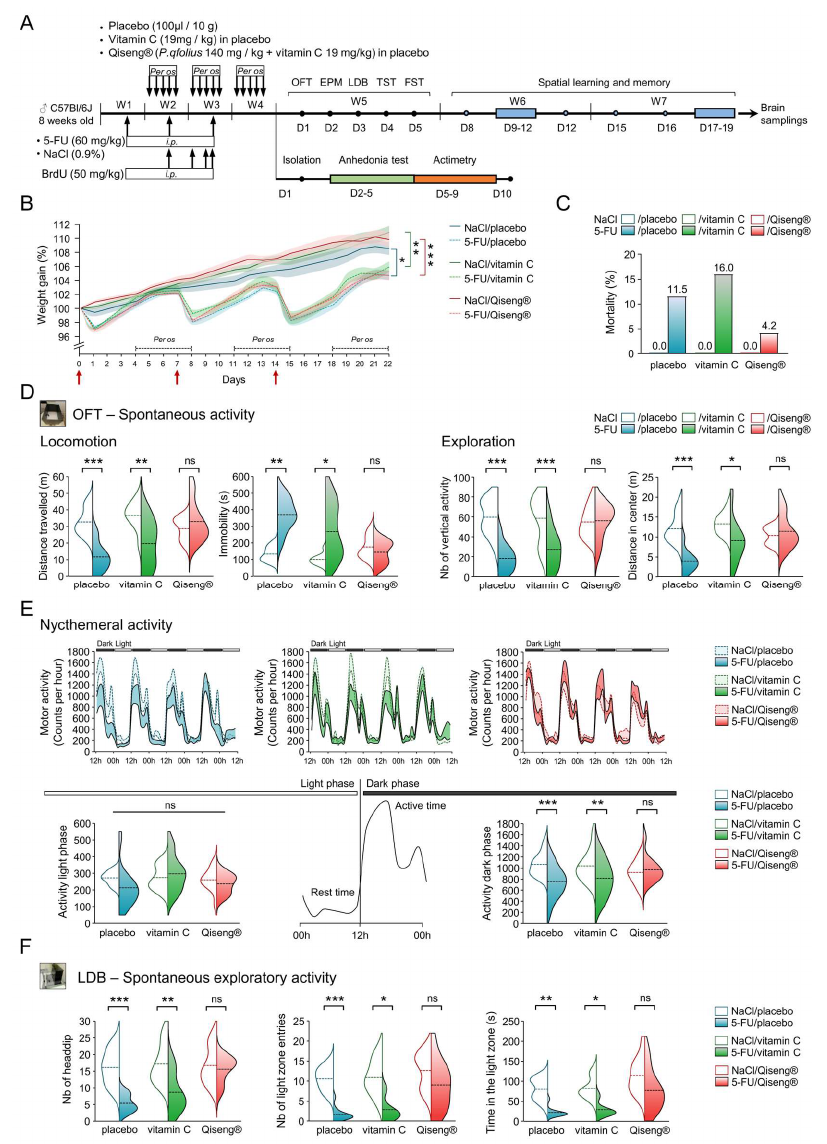
Figure 1. Preventive impact of Qiseng ® on the behavioral consequences of 5-FU for spontaneous activity and exploration and nycthemeral rhythms and activity. ( A ) Schematic representation of the schedule and experimental protocol showing the timeline for the different treatments and behavior tests assessing emotional reactivity and cognitive functions in mice. C57BL/6J Rj mice received intraperitoneal injection of 5-FU (60 mg/kg, red arrow) once a week for 3 weeks (i.p., arrow ) and/or per os administration of Placebo, vitamin C (19 mg/kg) in placebo or Qiseng ® ( P. qfolius 140 mg/kg + vitamin C 19 mg/kg) once a day, 5 times a week for 3 weeks. Mice also received consecutive BrdU injections (50 mg/kg, once a day for 4 days, arrow ) in weeks 2 and 3. Behavioral evaluations started at week 4 (W4), with the first group of mice evaluated in the open field test (OFT) on D1, elevated plus maze (EPM) on D2, light/dark box test (LDB) on D3, tail suspension test (TST) on D4 and forced swim test (FST) on D5. Cognitive functions were investigated at W6 and W7, and mouse brains were collected at D19. For a second series of experiments, mice were individually housed from D1 of W4 and evaluated in the sucrose preference test (D2 to D5) followed by testing in actimetry (D5 to D9). ( B ) Curves of body weight gain during the different treatment periods. NaCl/placebo ( n = 22), 5-FU/placebo ( n = 24), NaCl/vitamin C ( n = 23), 5-FU/vitamin C ( n = 23), NaCl/Qiseng ® ( n = 21), 5-FU/Qiseng ® ( n = 24). Bi-directional repeated-measures ANOVA; * p < 0.05, ** p < 0.01, *** p < 0.001. ( C ) Percentage of mortality occurring over the course of the 5-FU injection in the absence or the presence of placebo, vitamin C or Qiseng ® . ( D ) Impact of 5-FU in the absence or the presence